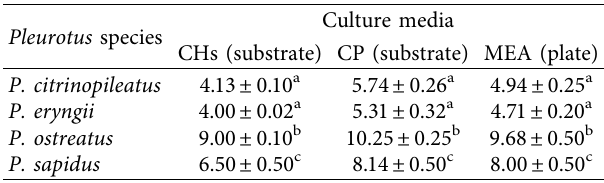
Table 1: Average mycelia growth rate per day in diameter (mm) of the four Pleurotus species on different